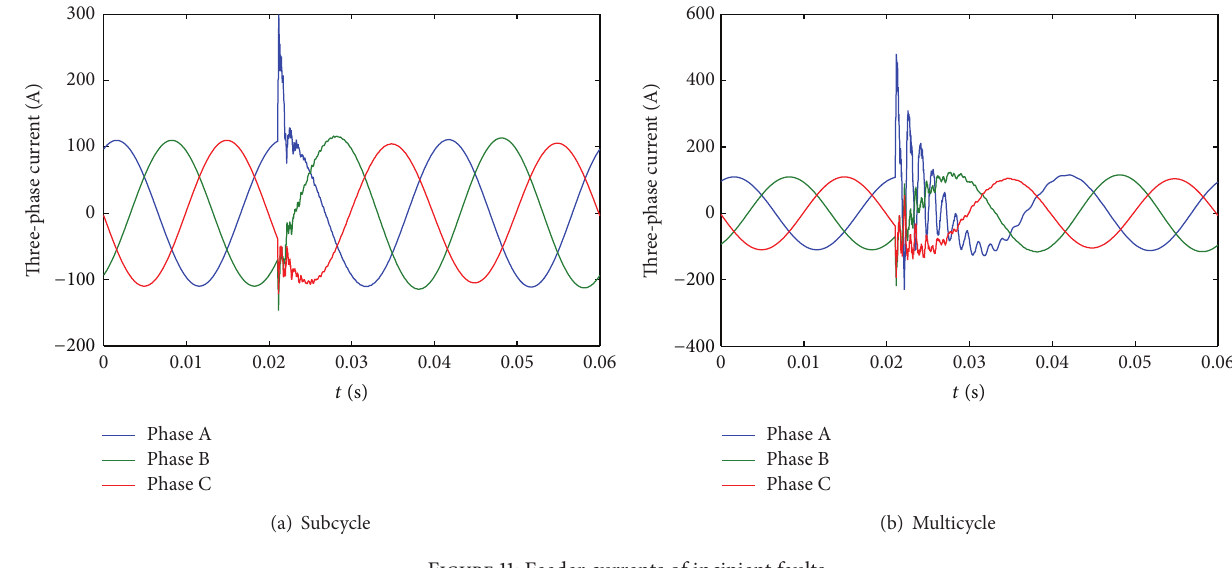
Figure 11: Feeder currents of incipient faults. Table 10: SK relative energy entropy with incipient